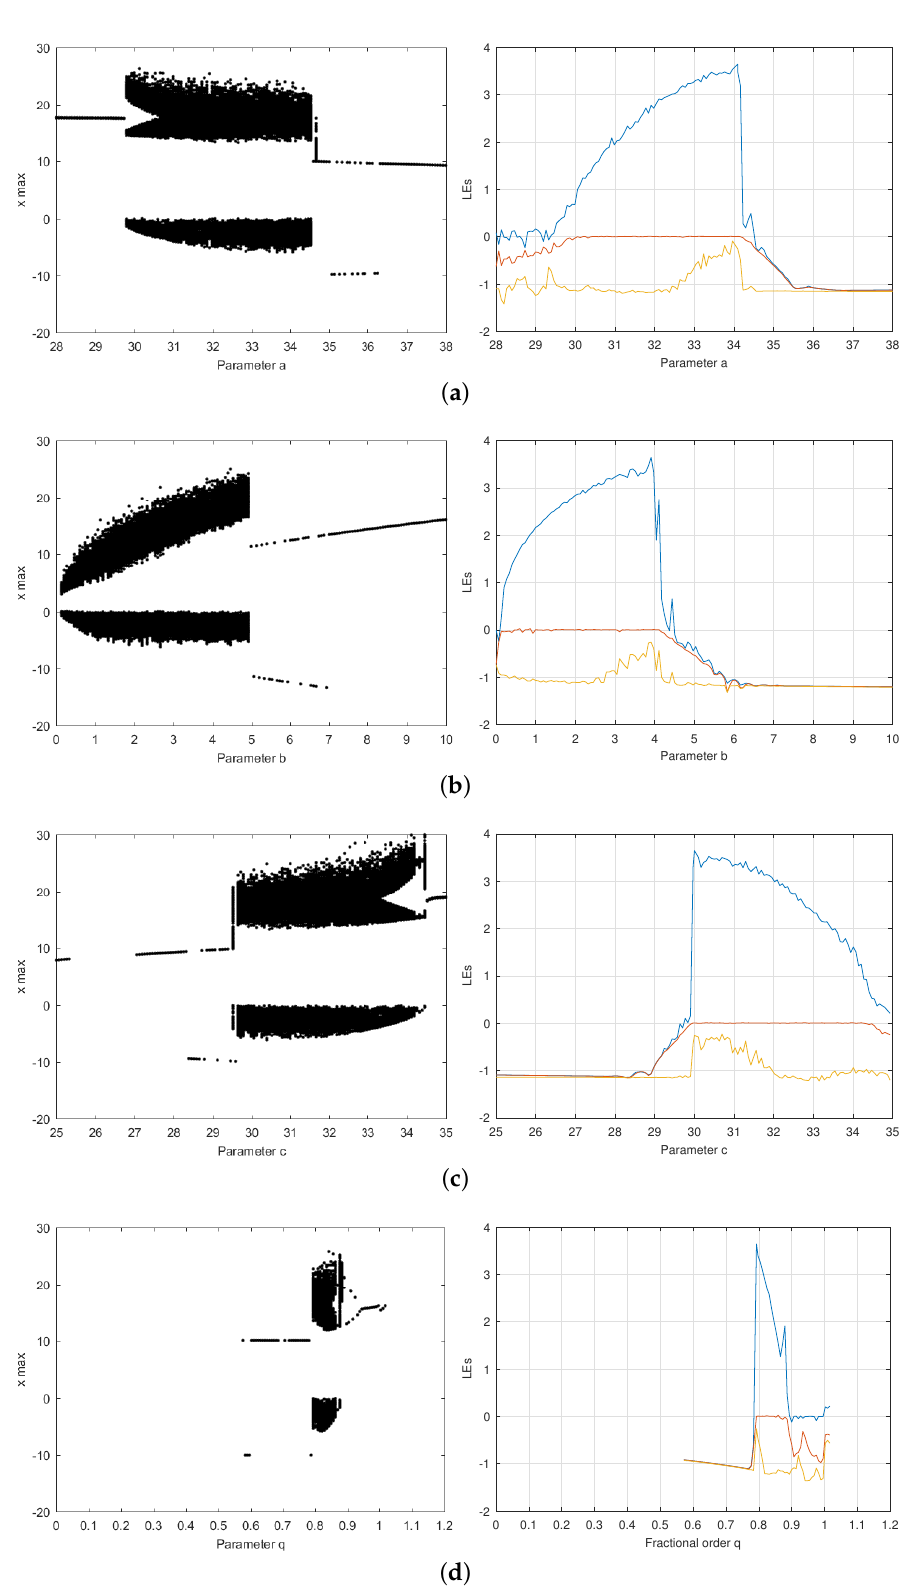
Figure 4. Bifurcation diagram and LE spectra of fractional order Chen system for DE best result at 400 to 500 generations. For the LE spectra, L 1 is in blue color, L 2 in red, and L 3 in yellow. a = 34.0919, b = 3.9072, c = 30.0000, q = 0.7923 and MLE = 3.6451. ( a ) Parameter a ( b ) Parameter b ( c ) Parameter c ( d ) Fractional order q